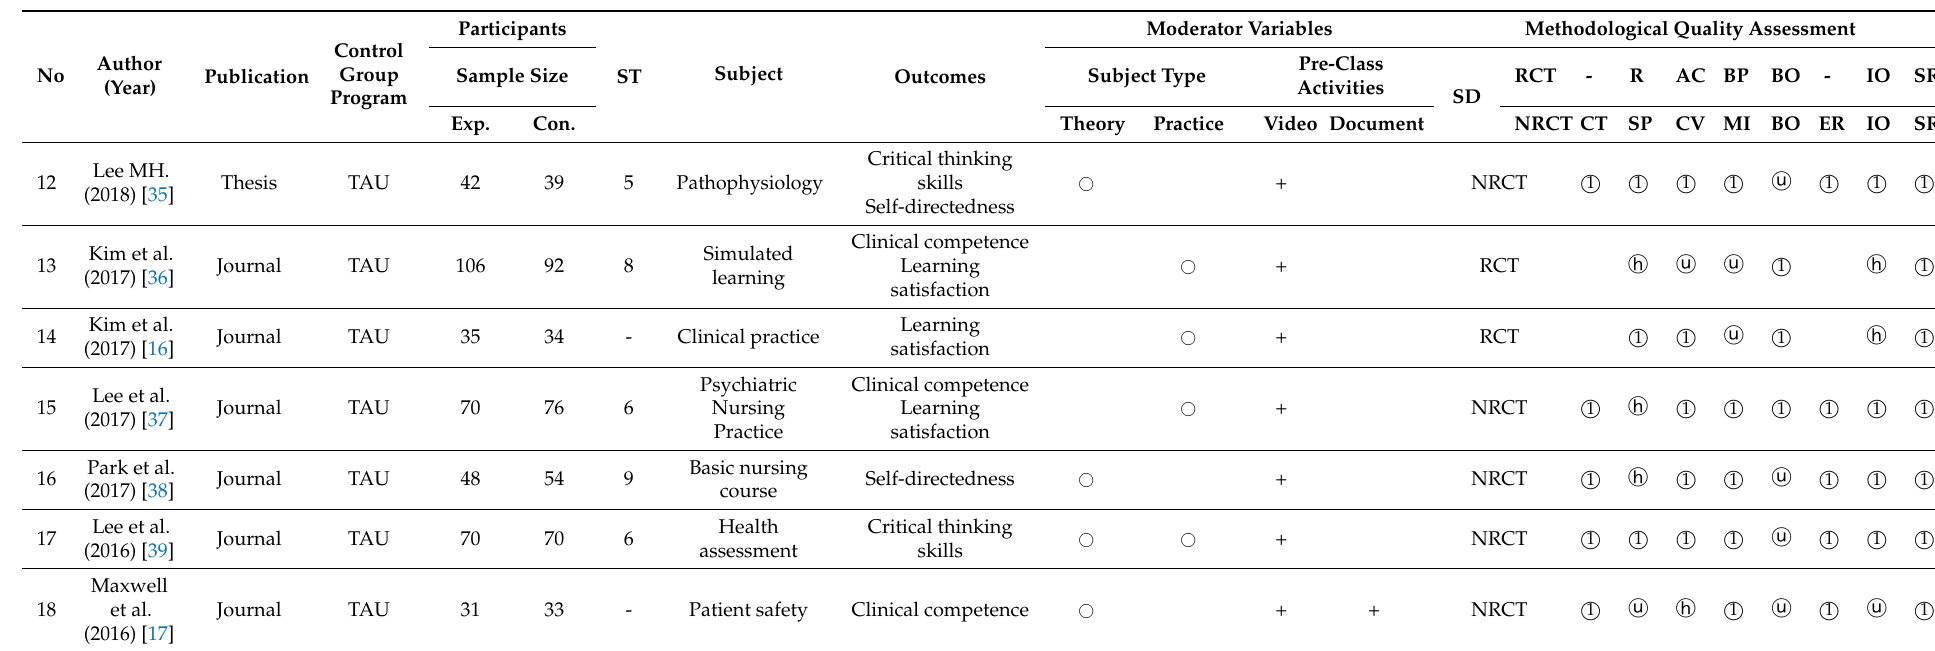
Table 1. Cont. Table 1. Descriptive summary of included studies.